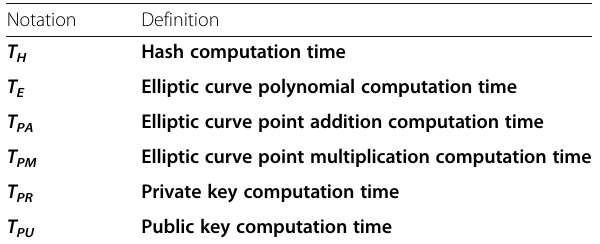
Table 3 Definition of some notations used in performance evaluation of the proposed scheme